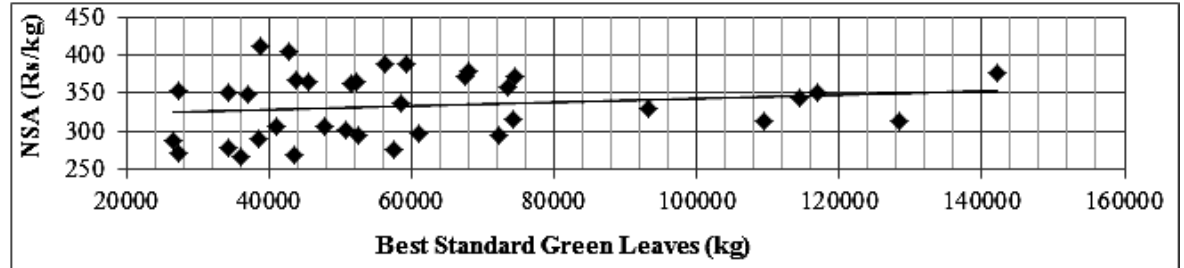
Fig 13: Relationship of Own Leaf Quantity with NSA in Western Best leaf standard maintaining in western region has a given positive relationship with NSA and showed price variation for equal quantity due to influence of some external factors that are highly affecting for price determination (see fig 14). High demand for flavor teas could be the reason for this variation.